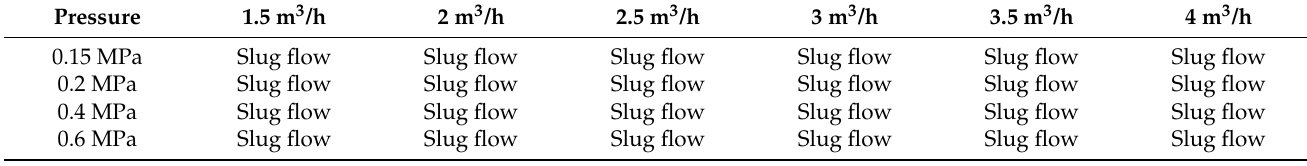
Table 3. Flow patterns of different pipe pressures inclined up to 20 ◦ .